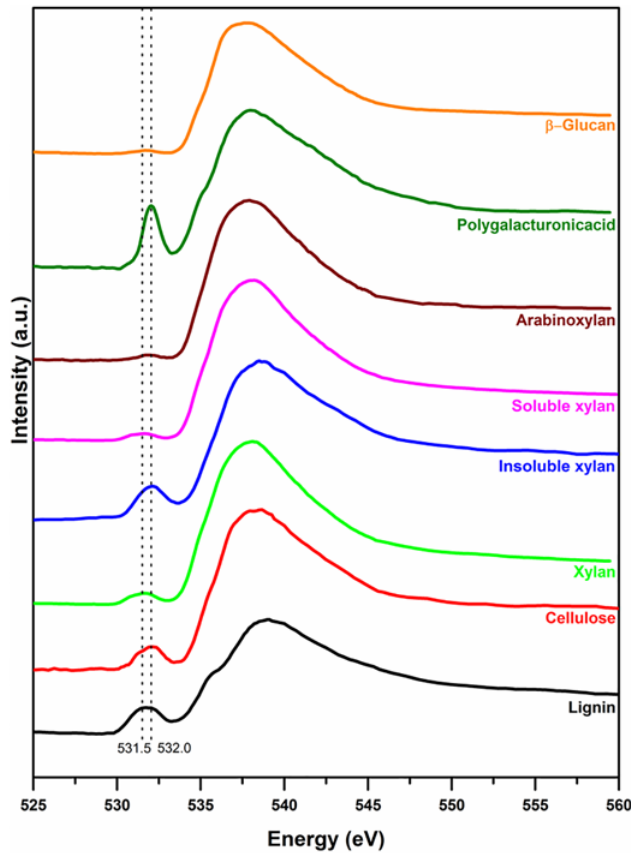
Fig 2. Oxygen 1s soft X-ray absorption spectra of lignin, cellulose, xylan, arabinoxylan, polygalacturonic acid, and β -glucan.